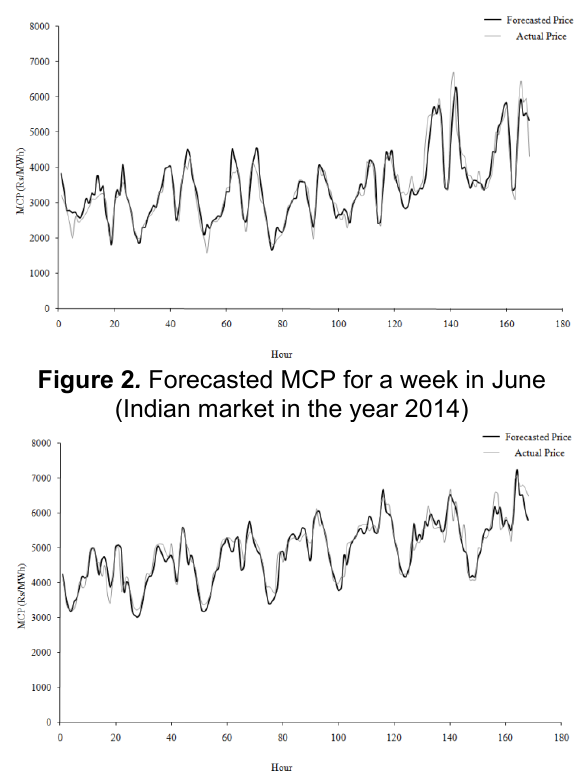
Figure 3 . Forecasted MCP for a week in September (Indian market in the year